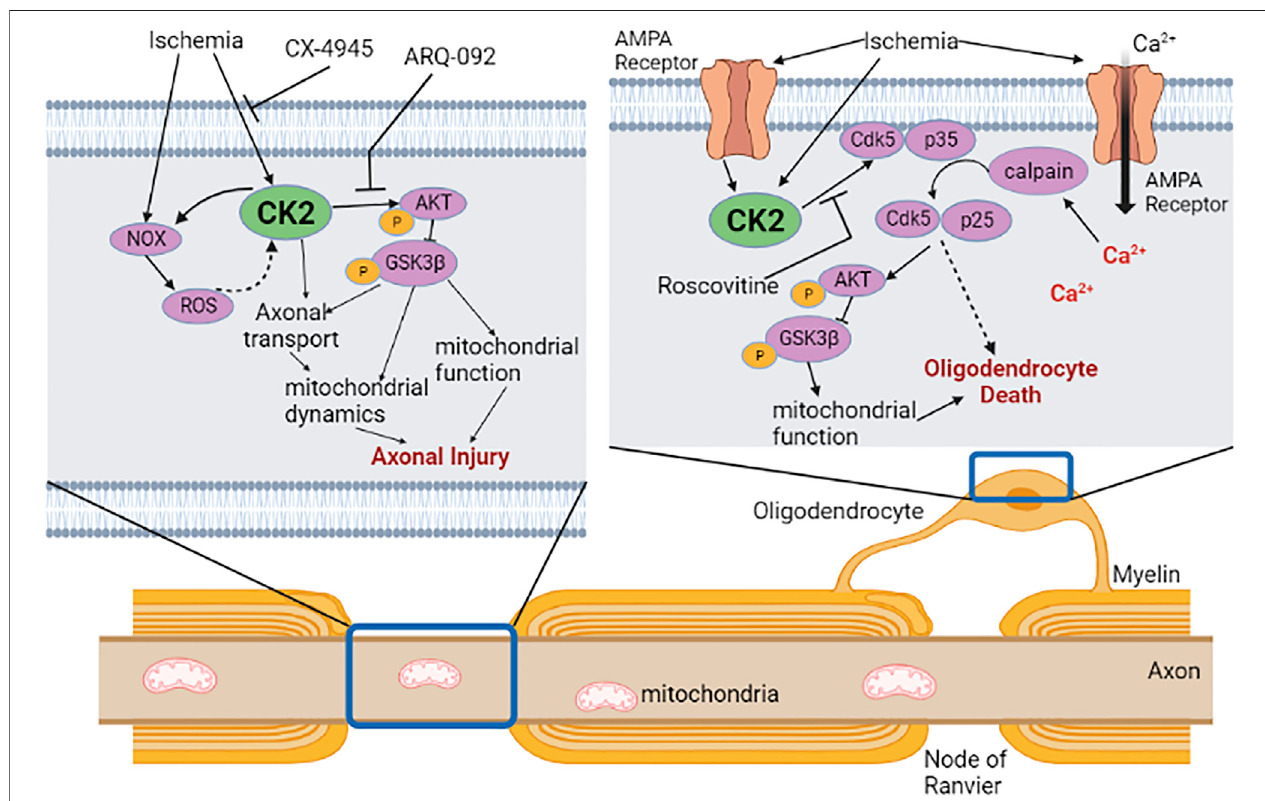
FIGURE 2 | CK2 signaling in white matter ischemia. In axon, ischemia can directly activate CK2 or NADPH oxidase (NOX) to increase reactive oxygen species (ROS). CK2 then activates Akt/GSK3 β signaling through phosphorylation to disrupt axonal mitochondrial dynamics and function. Speci fi c CK2 inhibitor CX-4945 or phosphorylated Akt inhibitor ARQ-092 confers axonal protection when applied during or after ischemia. In oligodendrocytes, ischemia activates CK2 directly or via activation of AMPA receptors leading to an in fl ux of Ca 2+ . Ca 2+ activates calpain, which subsequently acts on Cdk5/p35 complex to untether Cdk5/p25 complex fromthemembranethatcanthenphosphorylateAkt/GSK3 β inoligodendrocytes.Roscovitine,aninhibitorofCdk5,improvesaxonfunctionrecoveryfollowingischemia, presumably through protection of oligodendrocytes and/or axons. The effect of untethered Cdk5 on oligodendrocyte injury is yet to be investigated. Dotted arrow indicates potential interactions. Created with